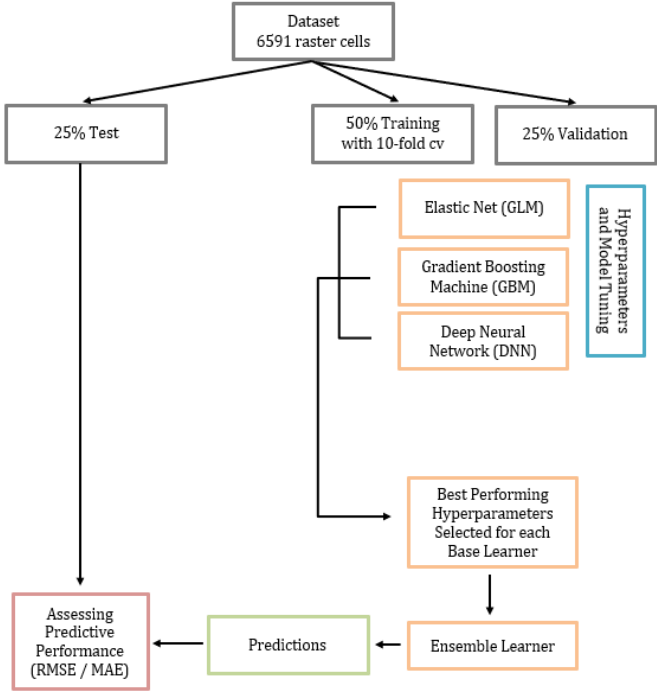
Figure 1. Data processing and model building flow for the ensemble ML.